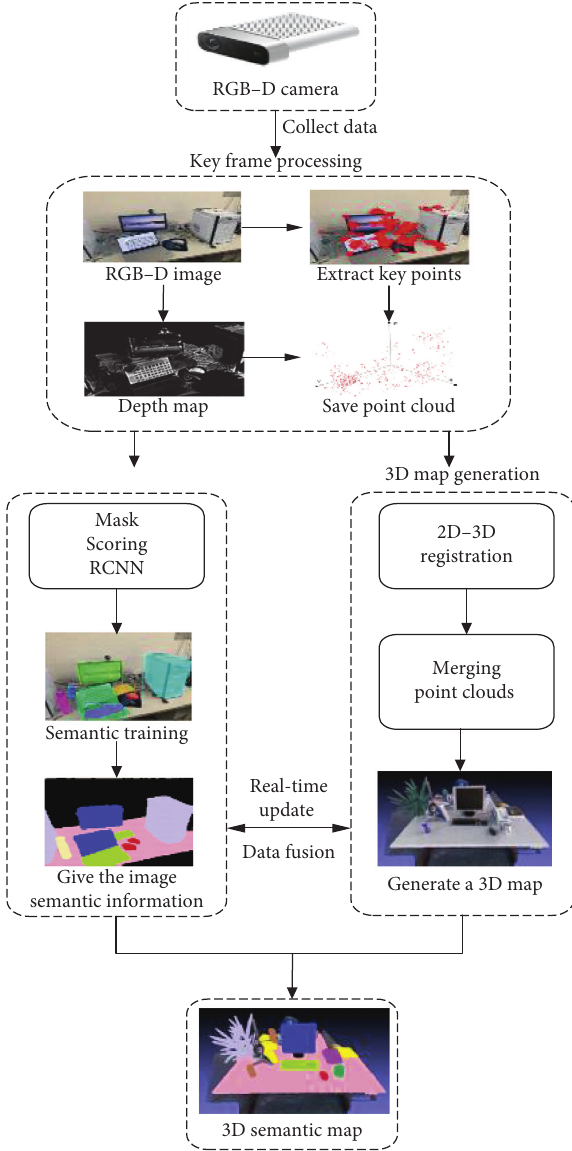
Figure 1: The entire framework of the proposed